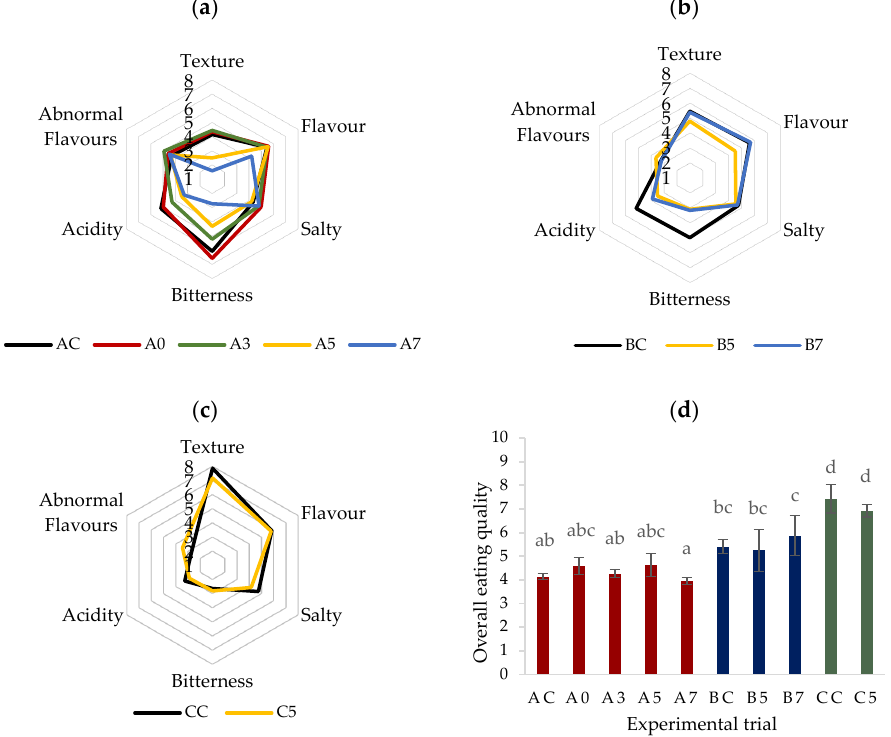
Figure 8. Sensory analysis of Cobrançosa table olives fermented under ( a ) plan A, ( b ) plan B, and ( c ) plan C and ( d ) overall eating quality under the different plans. Each column represents the mean ± standard deviation of two independent trials. a–d Means followed by different lowercase letters in each column differed significantly ( p < 0.05) among trials, as per Tukey’s post hoc